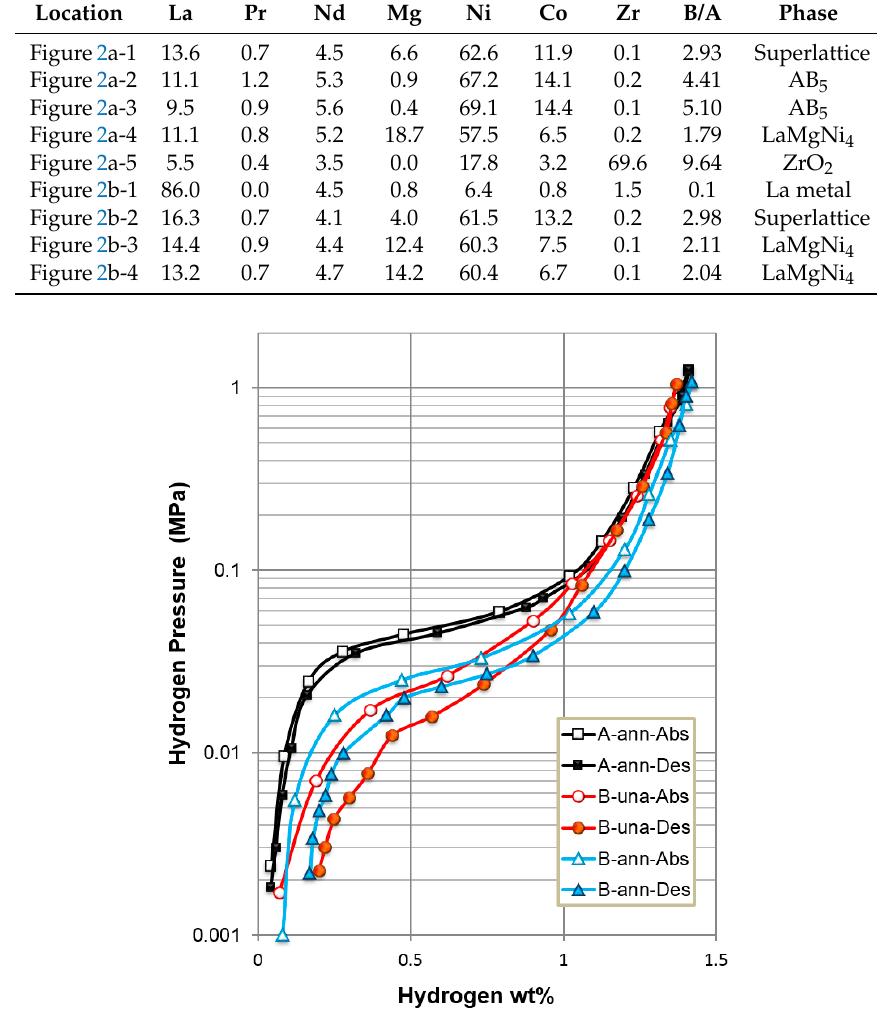
Figure 3. Pressure–concentration–temperature (PCT) isotherms measured at 30 °C. A-ann, B-una, and B-ann are annealed alloy A, pristine alloy B, and annealed alloy B, respectively. Abs and Des denote absorption and desorption, respectively.